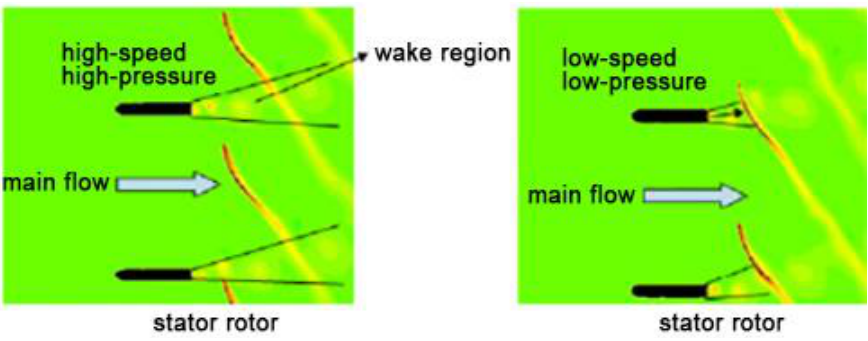
Figure 1. Interaction of rotor with stator blade trailing edge.